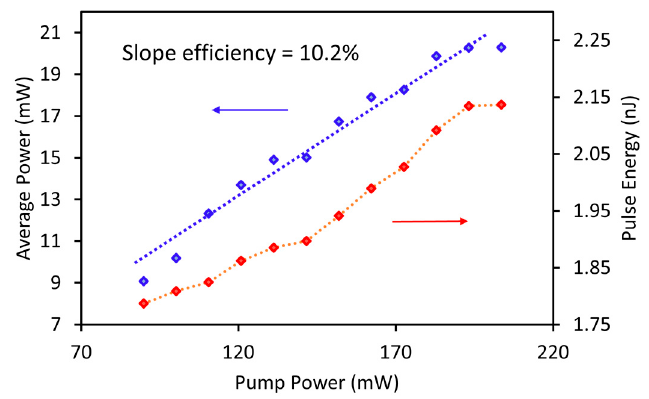
Figure 7. Correlation between average output power and pulse with 980 nm pump power for the mode-locked YDFL.